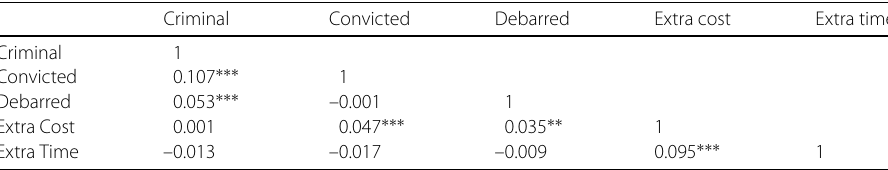
Table 4 Outcomes correlation